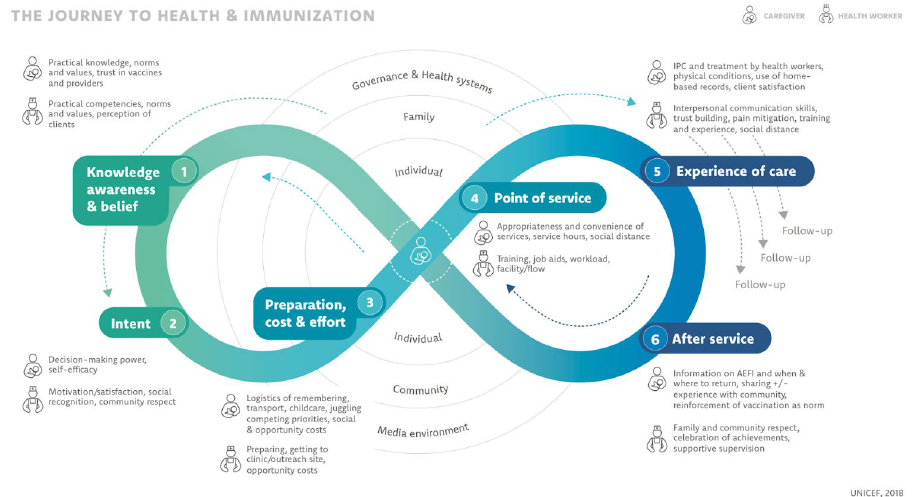
Figure 1. The UNICEF Journey to Health and Immunization framework. UNICEF, Demand for health services field guide: a human-centered approach. New York: UNICEF,